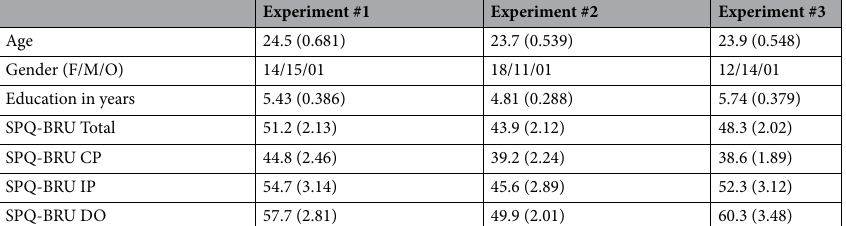
Table 1. Demographic information for participants in the experiments. Mean values (standard error). Gender options are Female, Male, or Prefer Not to Answer. Age is measured in years. Education is the number of years of education after the age of 18. SPQ-BRU subscales are Cognitive Perceptual (CP), Interpersonal (I) and Disorganized